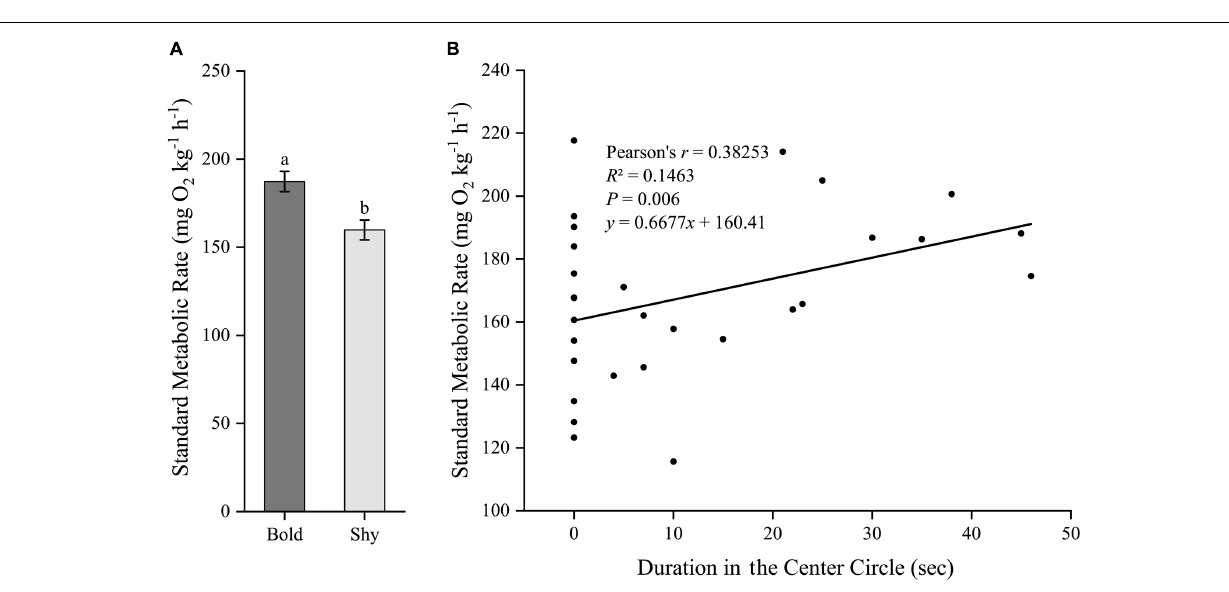
FIGURE 5 | The boldness and standard metabolic rate of black rockfish. (A) The standard metabolic rate in bold ( n = 9) and shy ( n = 20) groups. Different letters indicate significant differences ( P < 0.05; independent samples t -test). (B) Linear fit of the time duration in center circle (open-field boldness test) and the standard metabolic rate ( n =